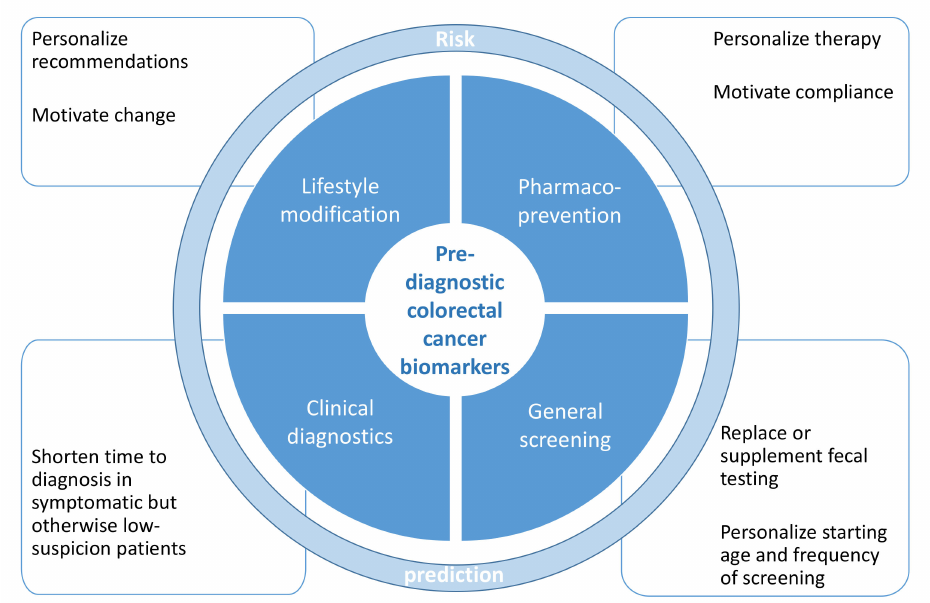
Figure 2. Potential applications of pre-diagnostic biomarkers for prevention and early detection of colorectal